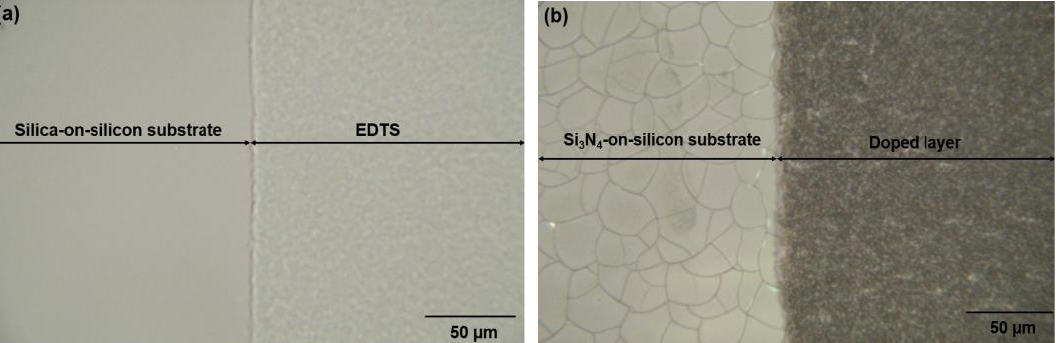
Figure 13. Surface images taken by optical microscope for samples fabricated with the same process parameters and target material for ( a ) silica-on-silicon ( b ) Si 3 N 4 -on-silicon substrate.